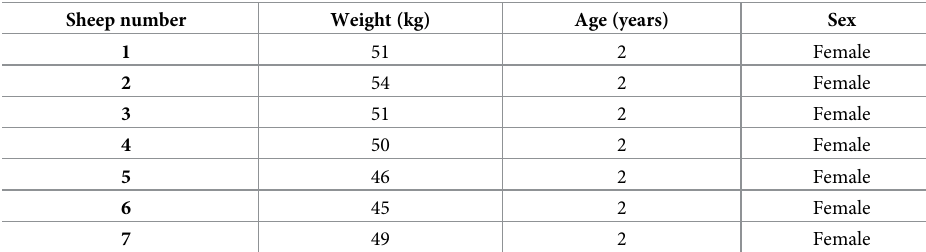
Table 1. Sheep characteristics.